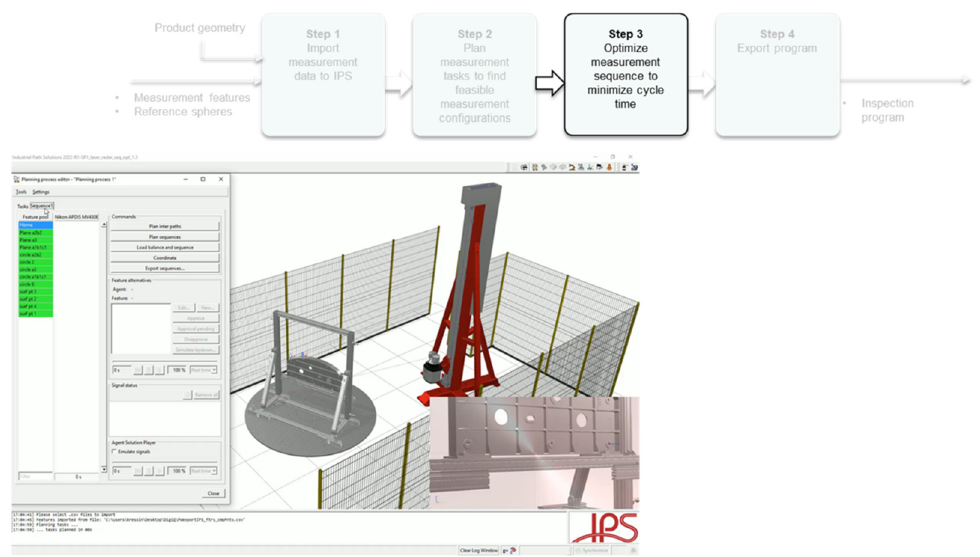
Figure 34. The evolved IPS LR system concept, Step 3.